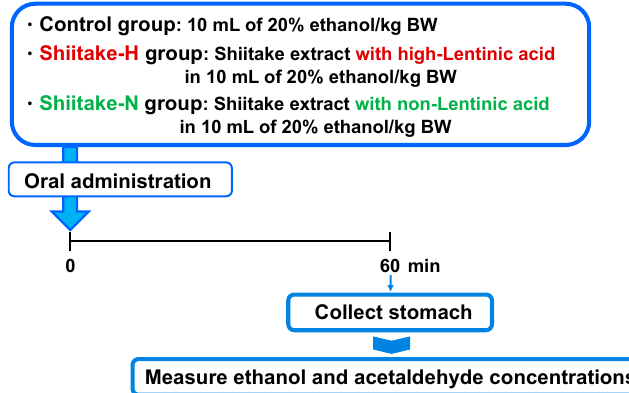
Figure 4. Experimental design to evaluate the effect of shiitake extracts on residual ethanol and acetaldehyde concentrations in the stomach.